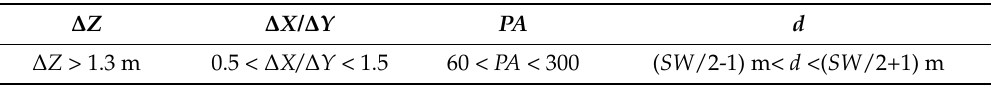
Table 2. Feature constraints for point clusters.